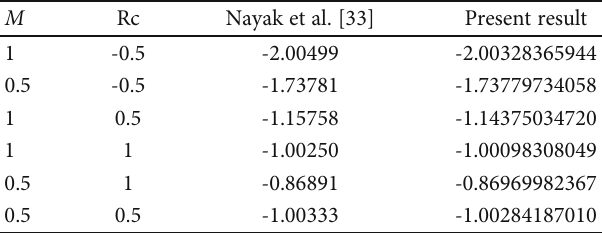
Figure 12: Concentration pro fi le for various values of E = 0 : 5, Kc = 1, f = 0, M = 2, Sc = 0 : 2 and K w Table 1: Comparison of the values of f ′′ ð 0 Þ when E = 100 . K p